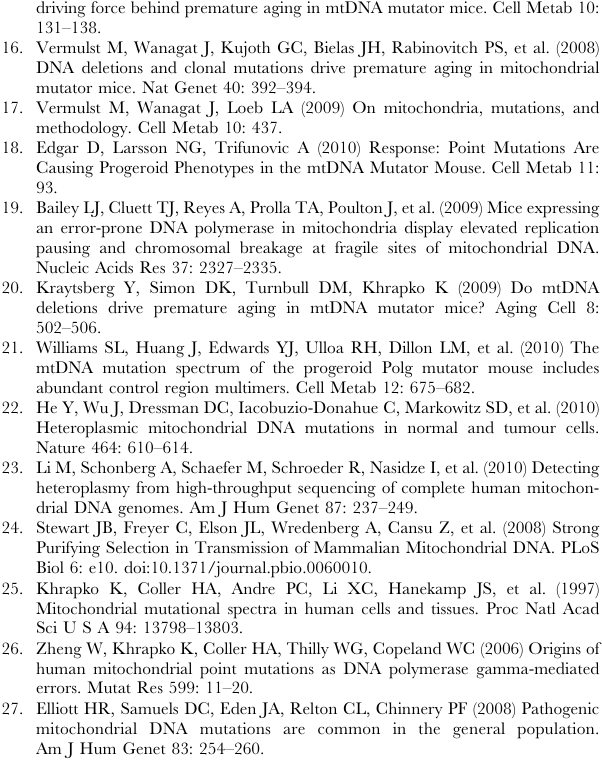
Figure S1 Sequence coverage overview. The lines represent the coverage for the different samples. Figure S2 Distribution of sites for insertions and deletions in the mtDNA genome.